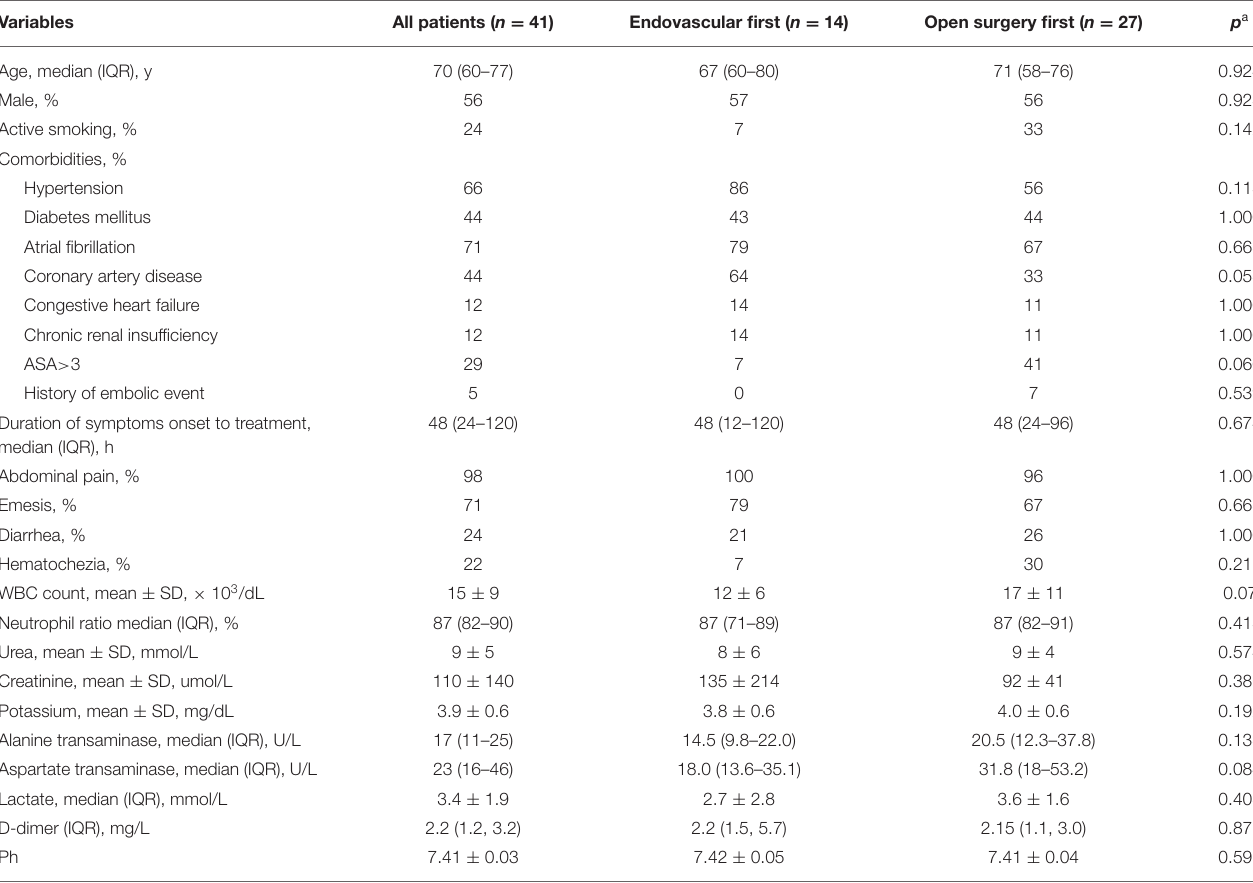
TABLE 1 | Demographic and clinical information of patients stratified by treatment type.